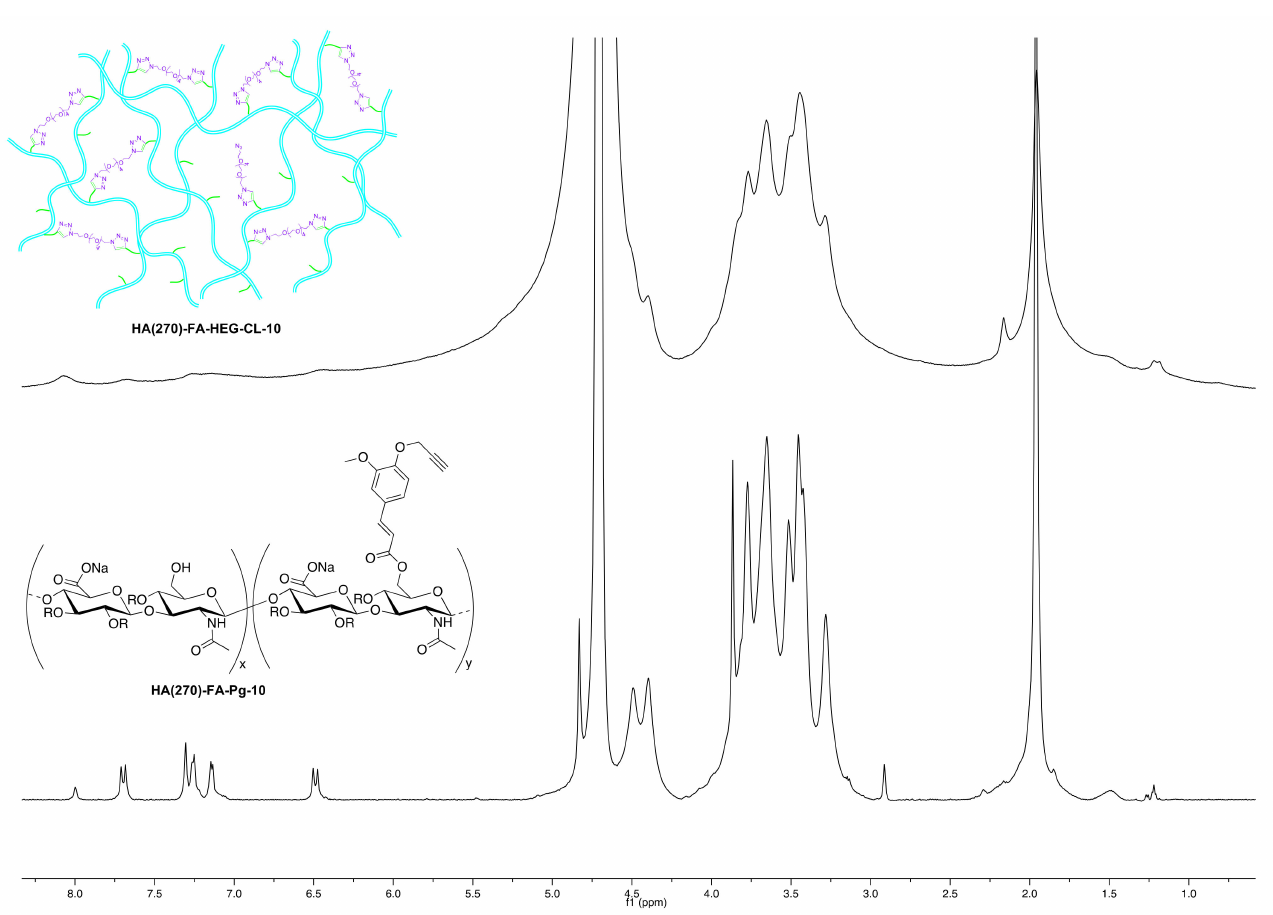
Figure 4. Comparison of the 1 H NMR spectrum obtained with the cross-linked HA(270)-FA - HEG- CL-10 material (D 2 O, 600 MHz) to that obtained with its corresponding synthetic precursor, the graft copolymer HA(270) - FA - Pg - 10